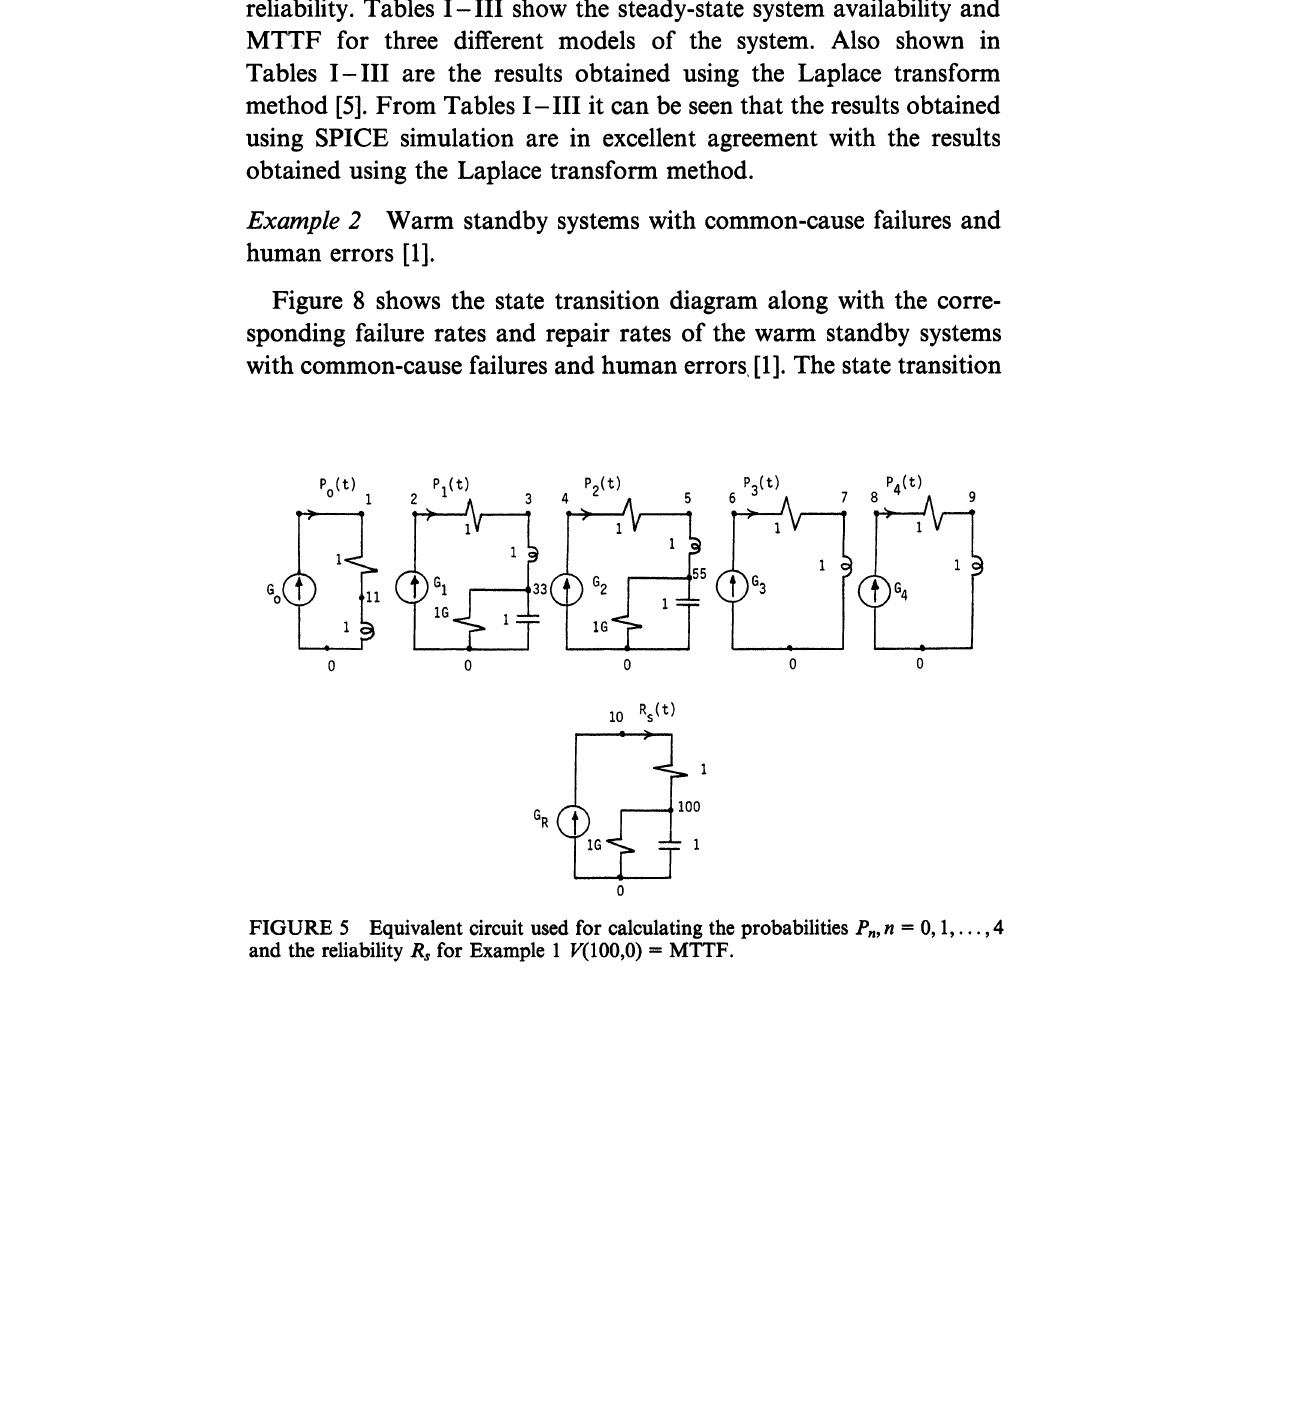
FIGURE 5 Equivalent circuit used for calculating the probabilities P,, n 0,1 4 and the reliability Rs for Example V(100,0)